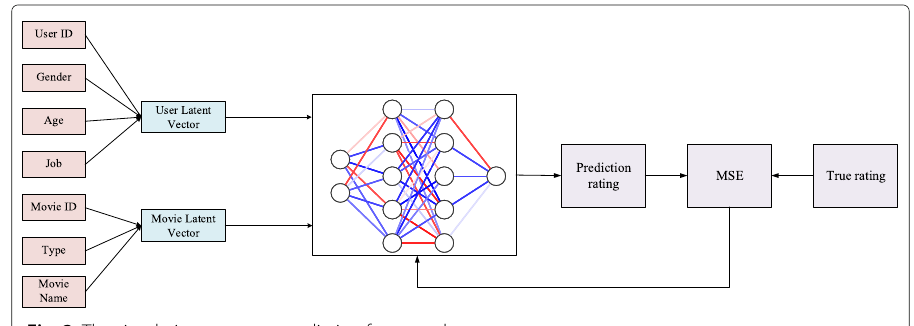
Fig. 3 The simulation contents prediction